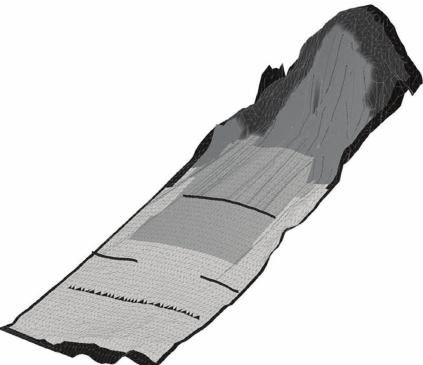
Figure 3: 3D simulations of the possible paths of the rockfall.